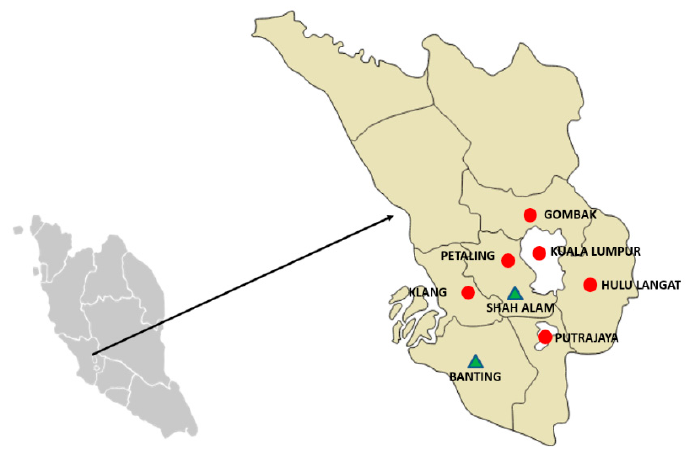
Figure 1. The map of Peninsular Malaysia (left), and the map of the state of Selangor (right). Red circles denote the sampling areas (wet markets) in six districts in Klang Valley, while green triangles denote the sampling area (abattoirs) in Selangor, Malaysia.